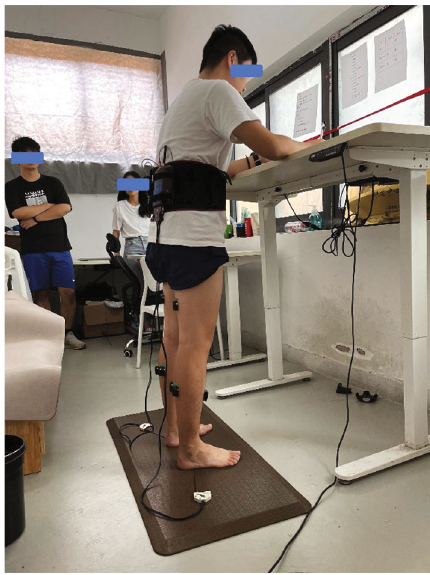
Figure 3: The photo of the testing